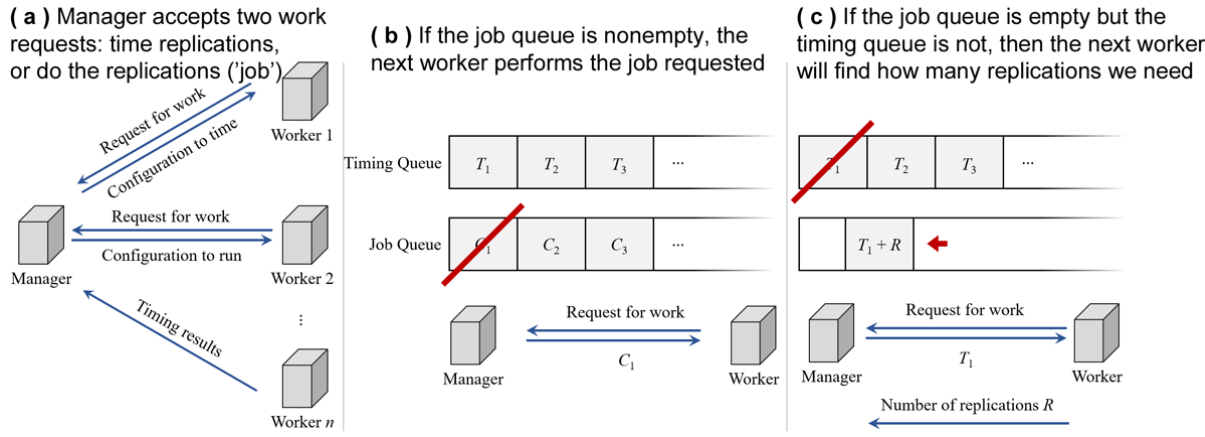
Figure 6. Our simulation management architecture to leverage parallelism on Microsoft